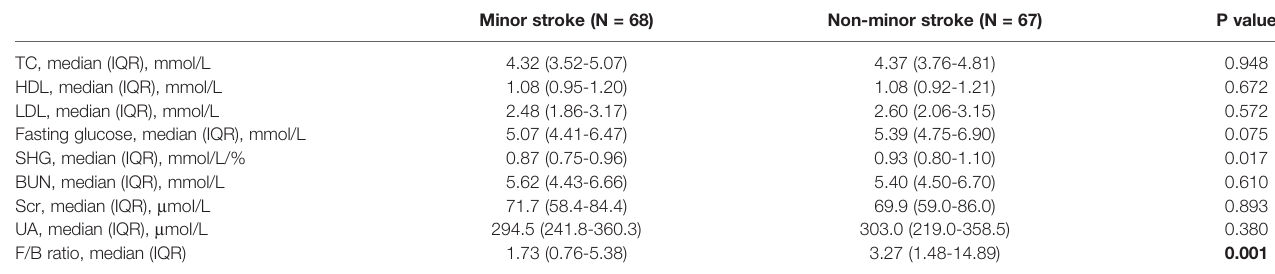
TABLE 2 | Metabolic parameters and microbial composition of patients.